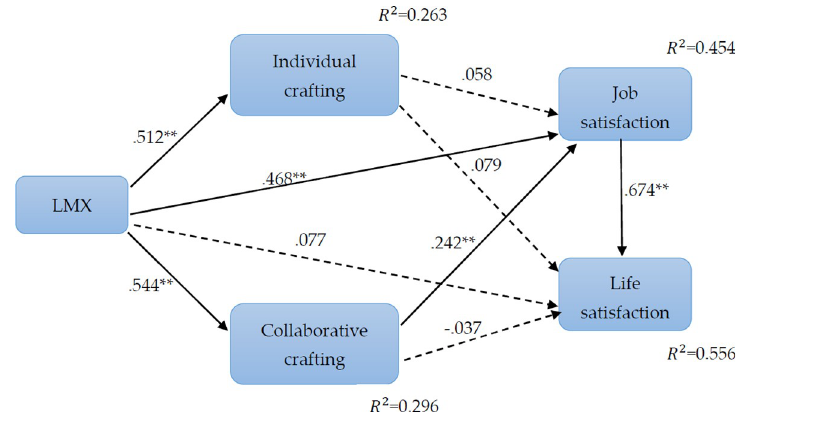
Fig 2. Path diagram of the structural model.